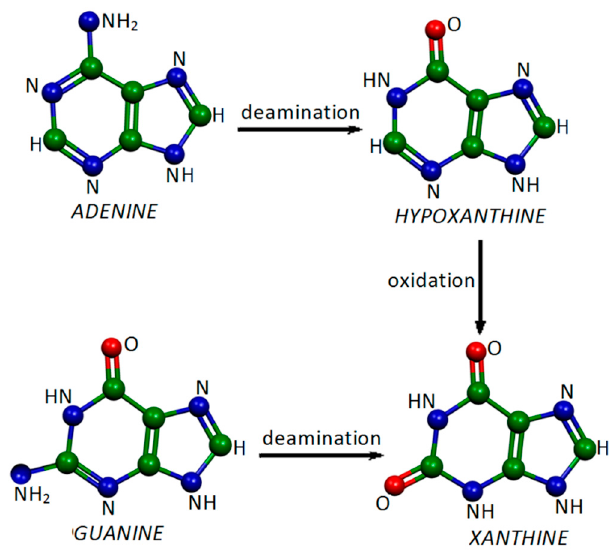
Figure 1. Formation of xanthine from adenine and guanine.